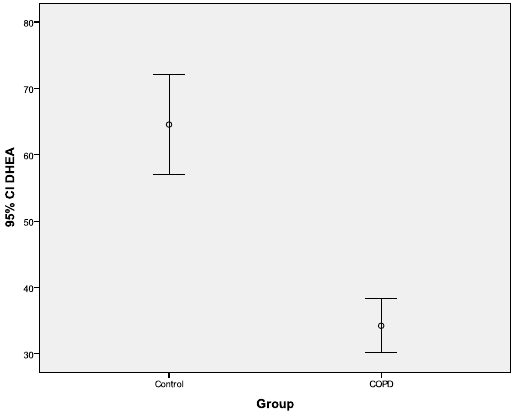
Figure 2. Mean DHEA values in the control and chronic obstructive pulmonary disease (COPD) group.